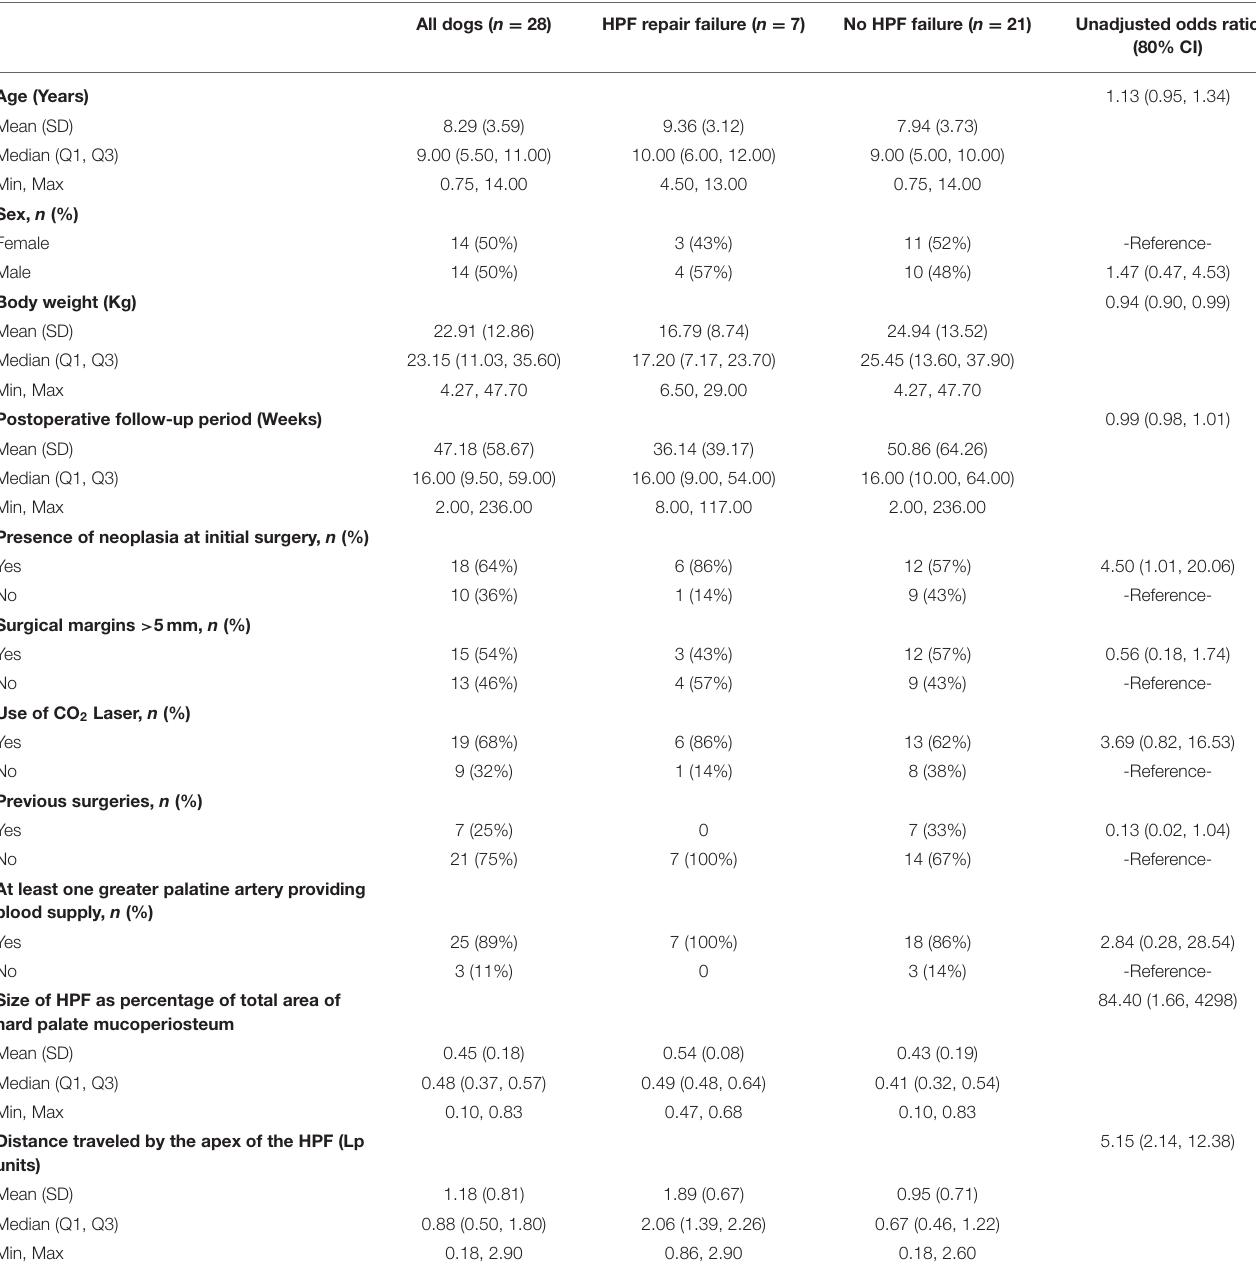
TABLE 1 | Sample characteristics by HPF failure